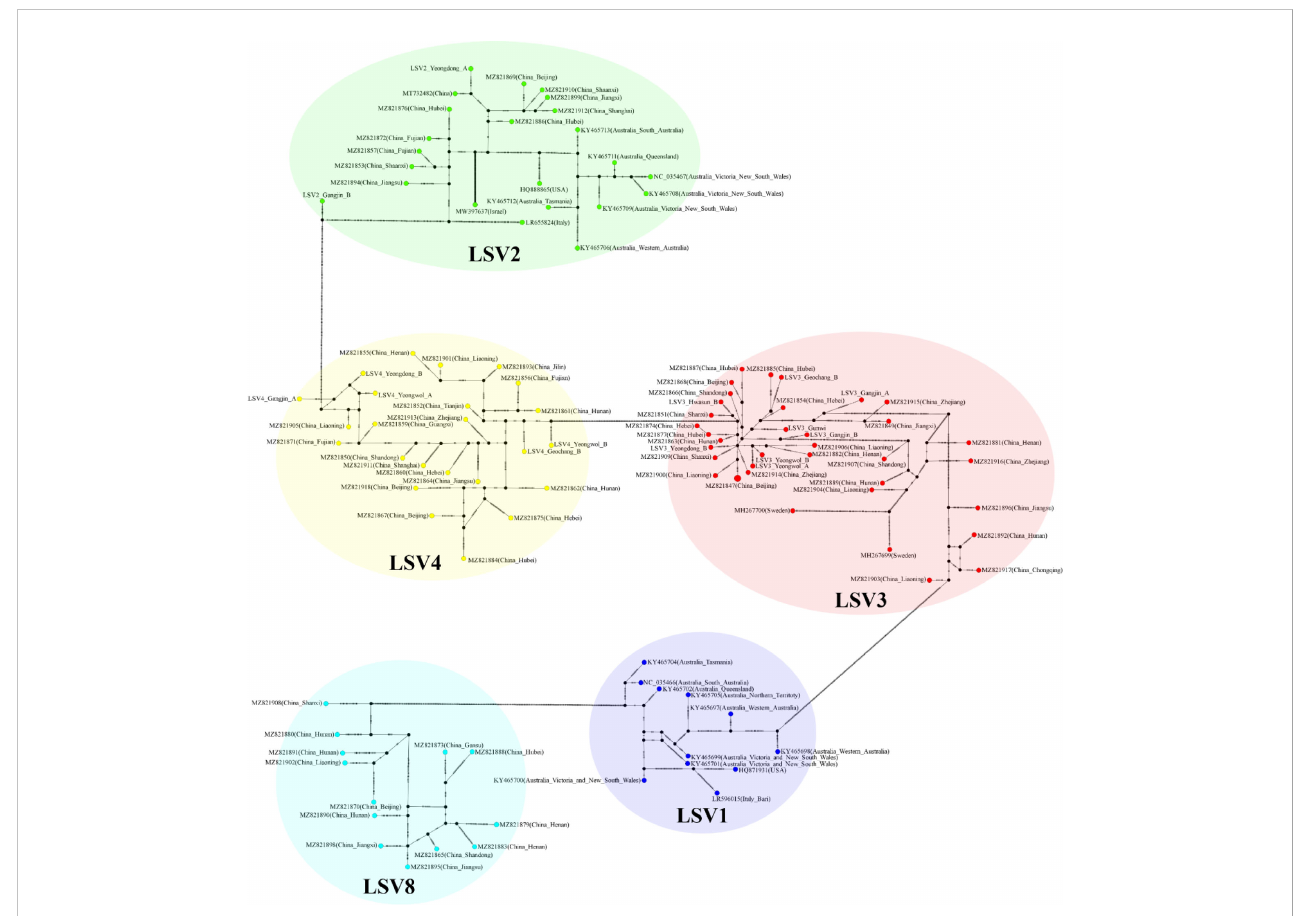
FIGURE 2 TCS haplotype network, with nodes colored by different Lake Sinai virus 1, 2, 3, 4 and 8 (LSV1, 2, 3, 4, and 8) RNA-dependent RNA polymerase (RdRp) regions clade. A total of 108 sequences for LSV1, 2, 3, 4 and 8 RdRp regions were used to construct the TCS network. The perpendicular dashes on the branches connecting two nodes represent the number of nucleotides difference between those nodes. This TCS network is analyzed and visualized by